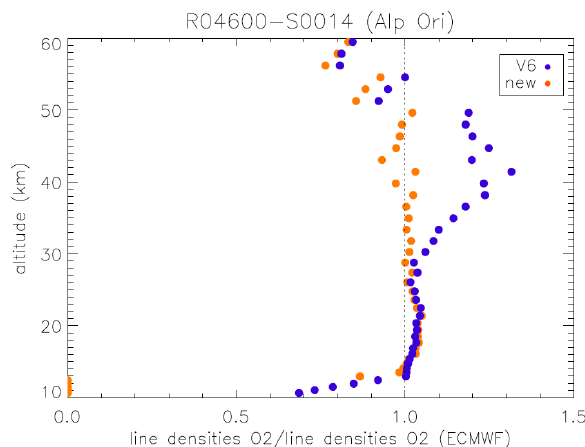
Fig. 42. Comparison of the retrieved line densities with the present version GOPR 6 of the algorithm, and a new version, where the modeled transmissions are adapted from ECMWF to the time and location of the occultation. This is one occultation of Alpha Orionis during orbit 4600.